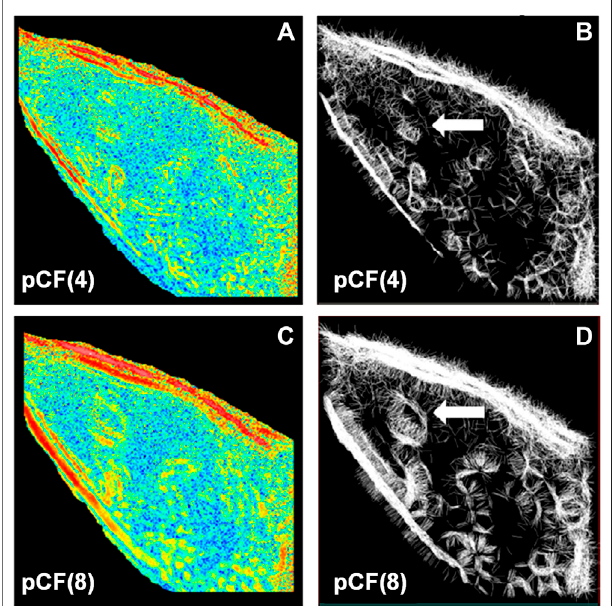
FIGURE14| .2D-pCFanalysisofEGFPdiffusinginMB231cells.( A )and ( C ) The eccentricity of the diffusion calculated by using a pair of locations having a distance of 4 and 8 pixels. ( B ) and ( D ) The connectivity map is calculatedbyusingapairoflocationshavingadistanceof4and8pixels. The white arrows in ( B ) and ( D ) indicate an obstacle that forces the molecules to go around. Adapted from Ref.